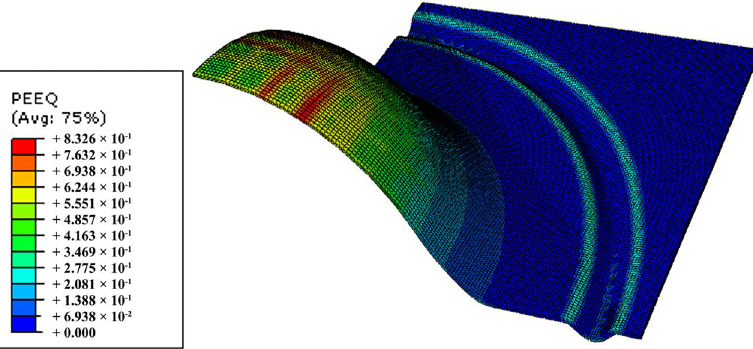
Figure 1. Simulation result of equivalent strain in uniaxial tension.